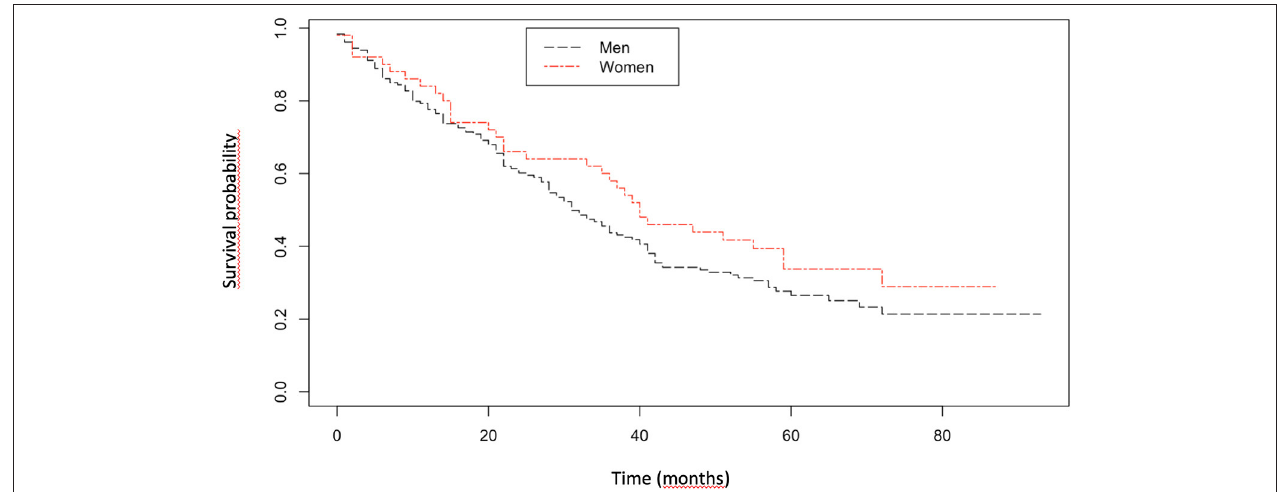
FIGURE 1 | Kaplan–Meier survival curve for women and men with idiopathic pulmonary